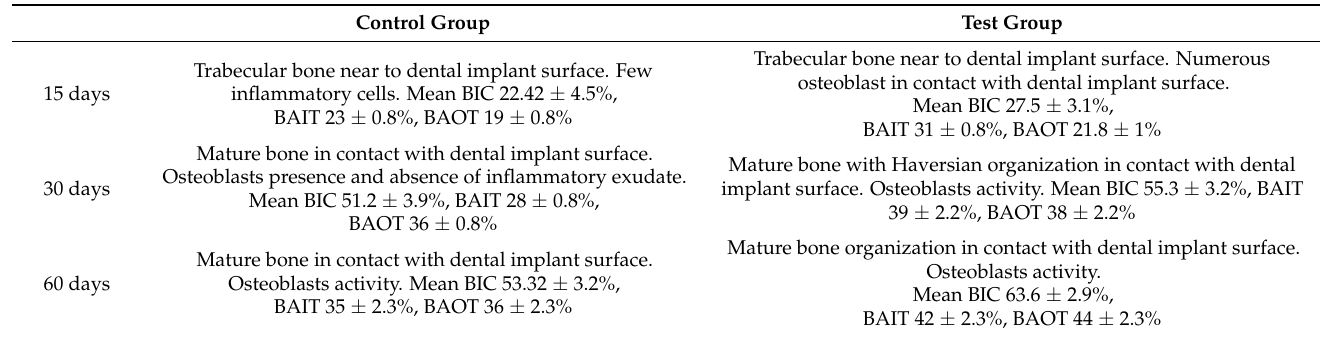
Table 5. BIC, BAIT and BAOT evaluation of both groups. Control Group Test Group Trabecular bone near to dental implant surface. Numerous Trabecular bone near to dental implant surface. Few osteoblast in contact with dental implant surface. 15 days inflammatory cells. Mean BIC 22.42 ± 4.5%, Mean BIC 27.5 ± 3.1%, BAIT 23 ± 0.8%, BAOT 19 ± 0.8% BAIT 31 ± 0.8%, BAOT 21.8 ± 1% Mature bone in contact with dental implant surface. Mature bone with Haversian organization in contact with dental Osteoblasts presence and absence of inflammatory exudate. implant surface. Osteoblasts activity. Mean BIC 55.3 ± 3.2%, BAIT Mean BIC 51.2 ± 3.9%, BAIT 28 ± 0.8%, 39 ± 2.2%, BAOT 38 ± 2.2% BAOT 36 ± 0.8% Mature bone organization in contact with dental implant surface. Mature bone in contact with dental implant surface. Osteoblasts Osteoblasts activity. Mean BIC 53.32 ± 3.2%, BAIT 35 ± 2.3%, BAOT 36 ± 2.3%